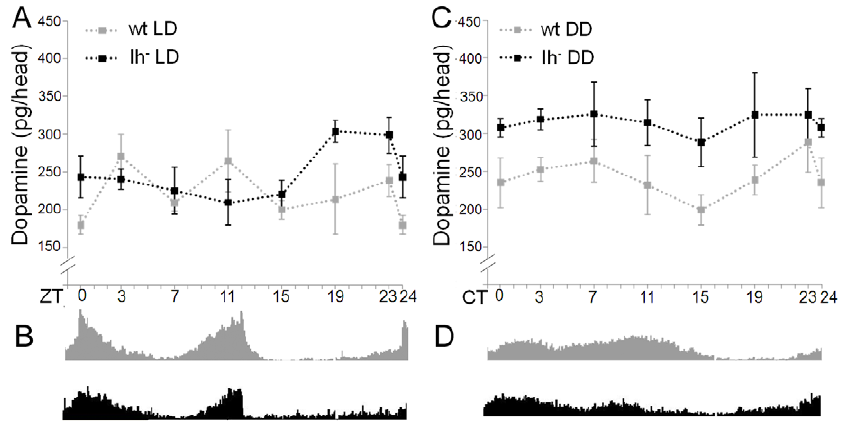
Figure 4. Lack of Ih current alters dopamine levels. Dopamine and activity was measured in 6 to8 days old flies at day 3 or 4 in each condition. Error bars indicate SEM. (A) In LD conditions, DmIh mutant flies (black dotted line) lose the characteristic cyclic pattern of dopamine at daytime, and show a notable increase in dopamine levels at night time. To facilitate comparison, dopamine in control flies is displayed with a gray dotted line. (B) Correspondingly, total activity plot of mutant flies (n=31; bottom black actogram) reveals subtle changes in the circadian locomotor activity when compared with control flies (top gray actogram): activity peak at lights on looks wider and blunted, while peak at lights off ends abruptly. In addition, mutant flies show increased activity during the night compared to control flies. (C) In DD conditions, the level of dopamine in DmIh mutant flies (black dotted line) increases drastically throughout the 24 hour period when compared to control flies (gray dotted line). (D) Total daily activity plot of mutant flies (n=53; bottom black actogram) shows that activity during the second half of the subjective day is reduced compared to control flies